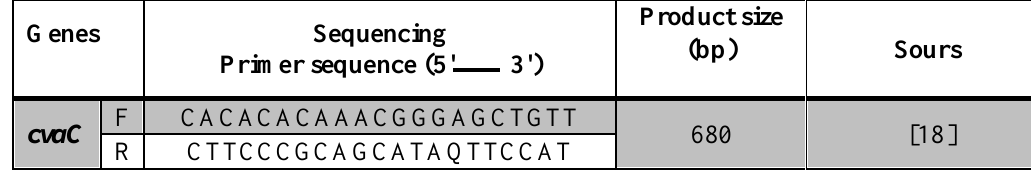
Table (1): Nucleotide sequence of the primer used for detection cvaC gene.